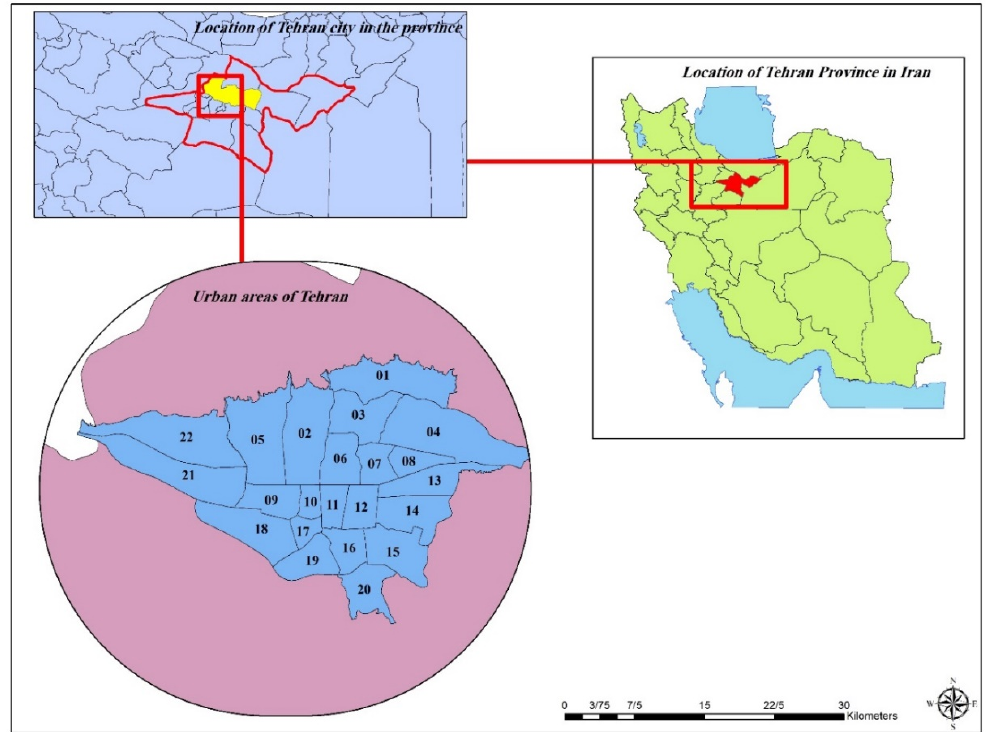
Figure 1. Location of Tehran metropolis.